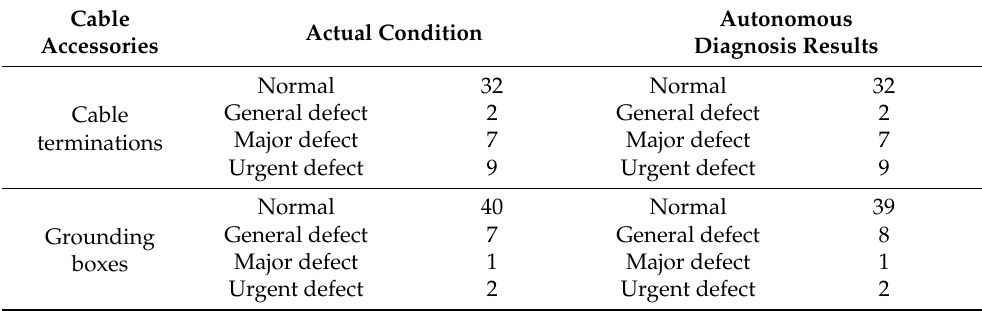
Table 4. Testing results of inspection